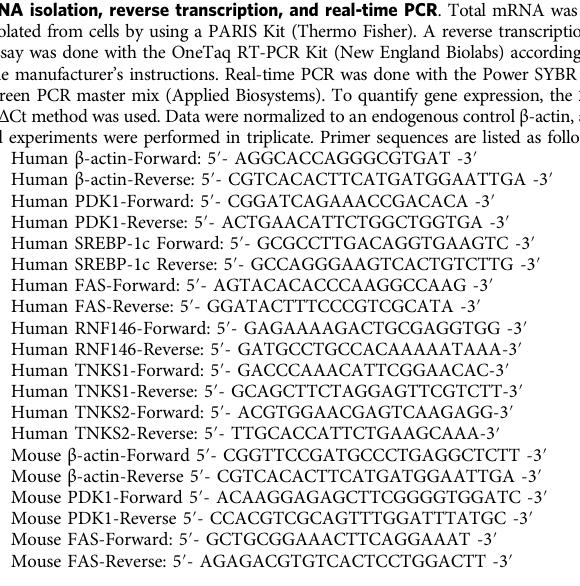
Fig. 6 Overexpression of tankyrase promotes tumor growth and predicts poor clinical outcome. a Inducible expression of TNKS1 leads to AMPK inactivation. LKR13 cells stably expressing inducible TNKS1 were treated without or with doxycycline (dox:100ng/ml) for the indicated hours, or with XAV939/G007-LK (5 μ M) for 12 h followed by western blotting. b , c Inducible expression of TNKS1 promotes cell proliferation ( b ) and colony formation ( c ). LKR13 cells stably expressing inducible TNKS1 were treated without or with doxycycline (dox:100 ng/ml), or treated in combination with